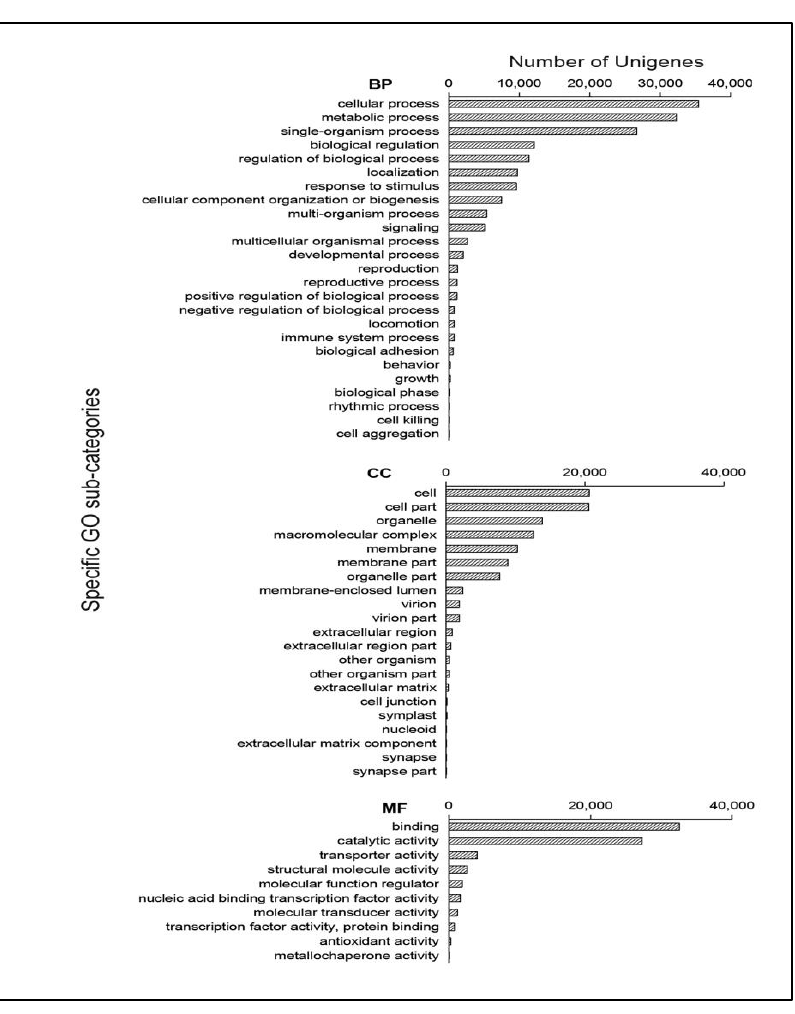
Figure 2. Gene function classification of all unigenes annotated by GO. “BP” represents “Biological Process” domain, “CC” represents “Cellular Component” domain and “MF” represents “Molecular Function” domain.